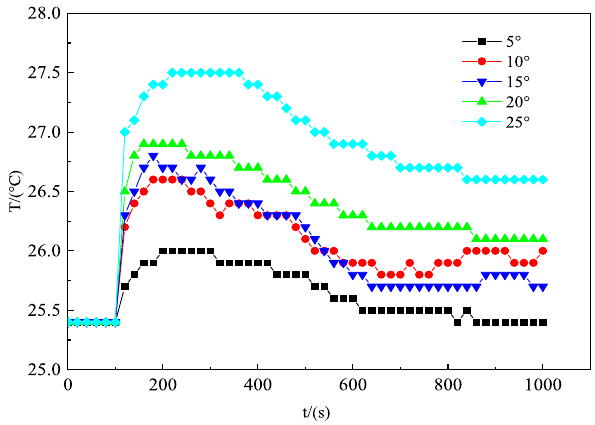
Figure 5. Temperature variation at measurement point 1 at different inclination angles.